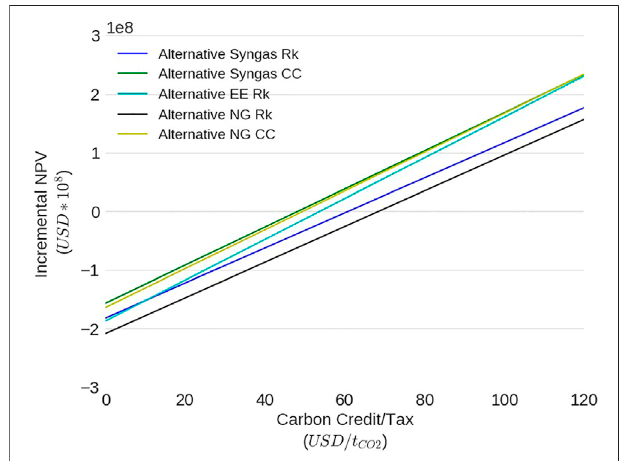
FIGURE 10 | NPV variation as a function of the carbon tax adopted. FIGURE 11 | Incremental NPV as a function of the carbon tax